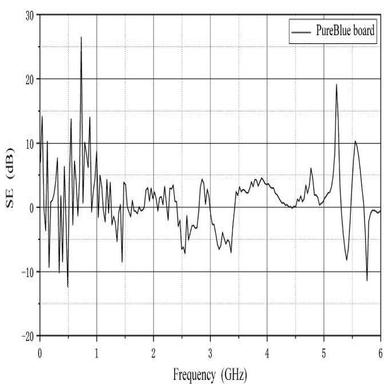
SE of a FR4 board. Fig. 15. Loading the SE of the PureBlue board.